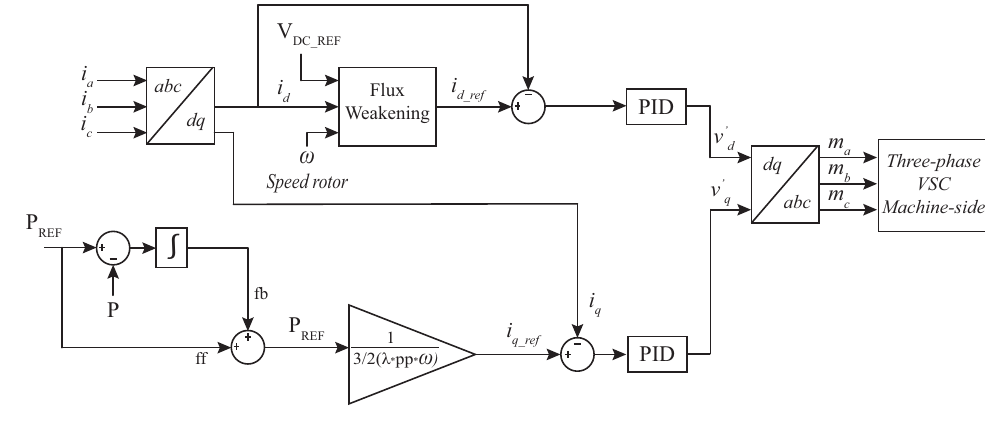
Figure 5. Machine-side